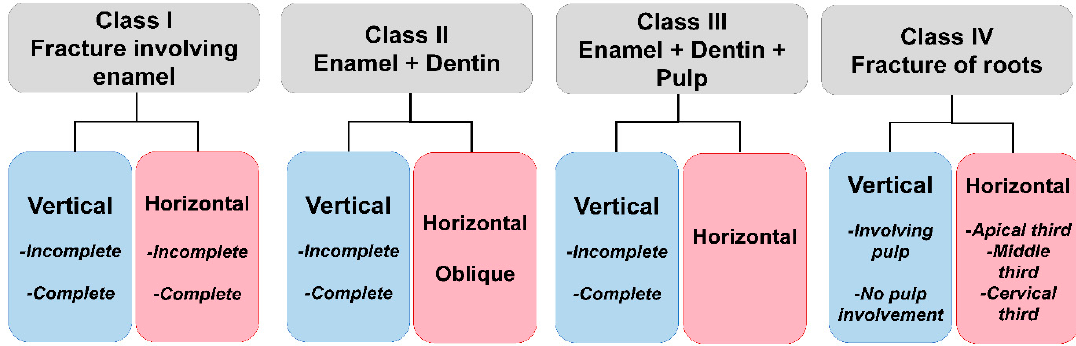
Figure 2. Classification of tooth fractures